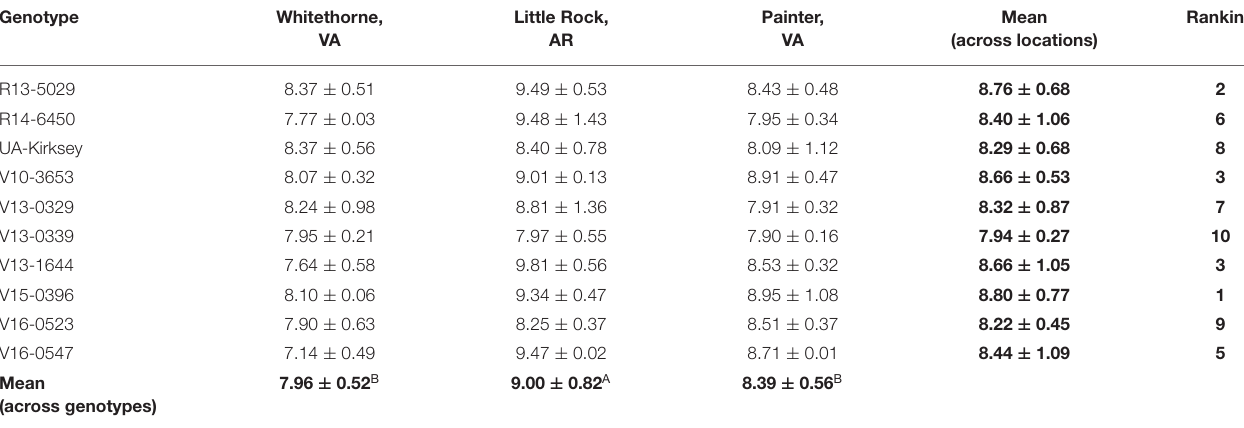
TABLE 9 | Neutral detergent fiber contents (%,d.b.) of 10 edamame genotypes planted in different locations. Genotype